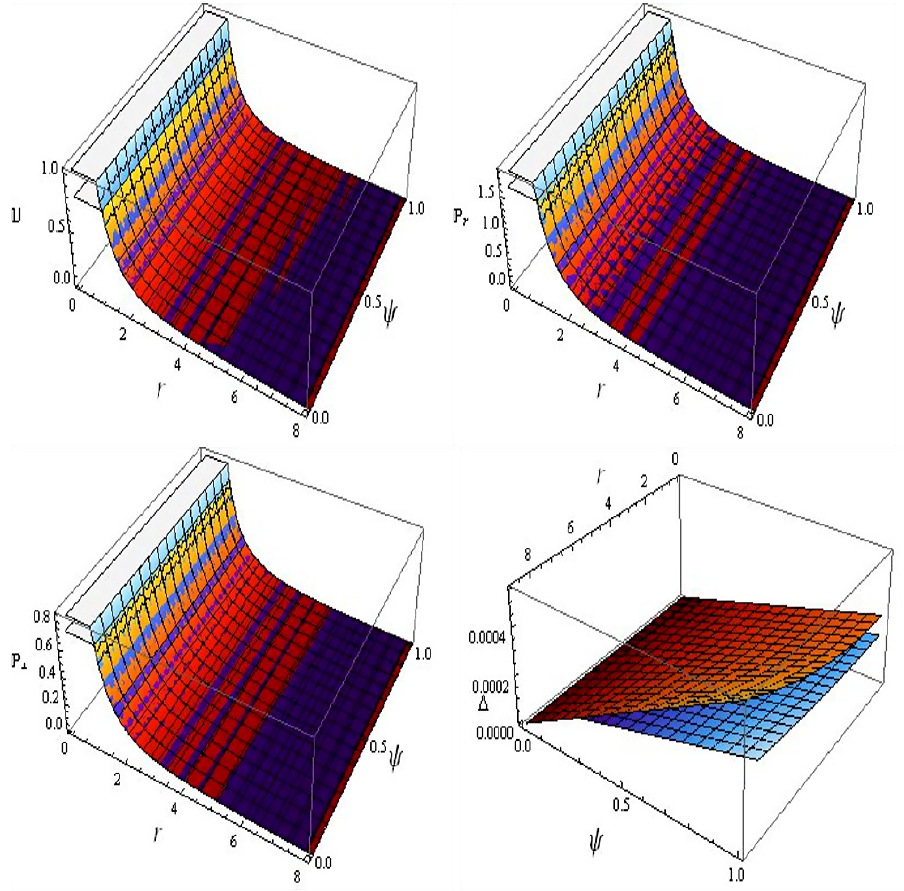
Figure 1. Physical analysis of U , P r , P ⊥ and (cid:52) versus ψ and r corresponding to two stellar candidates (Solution